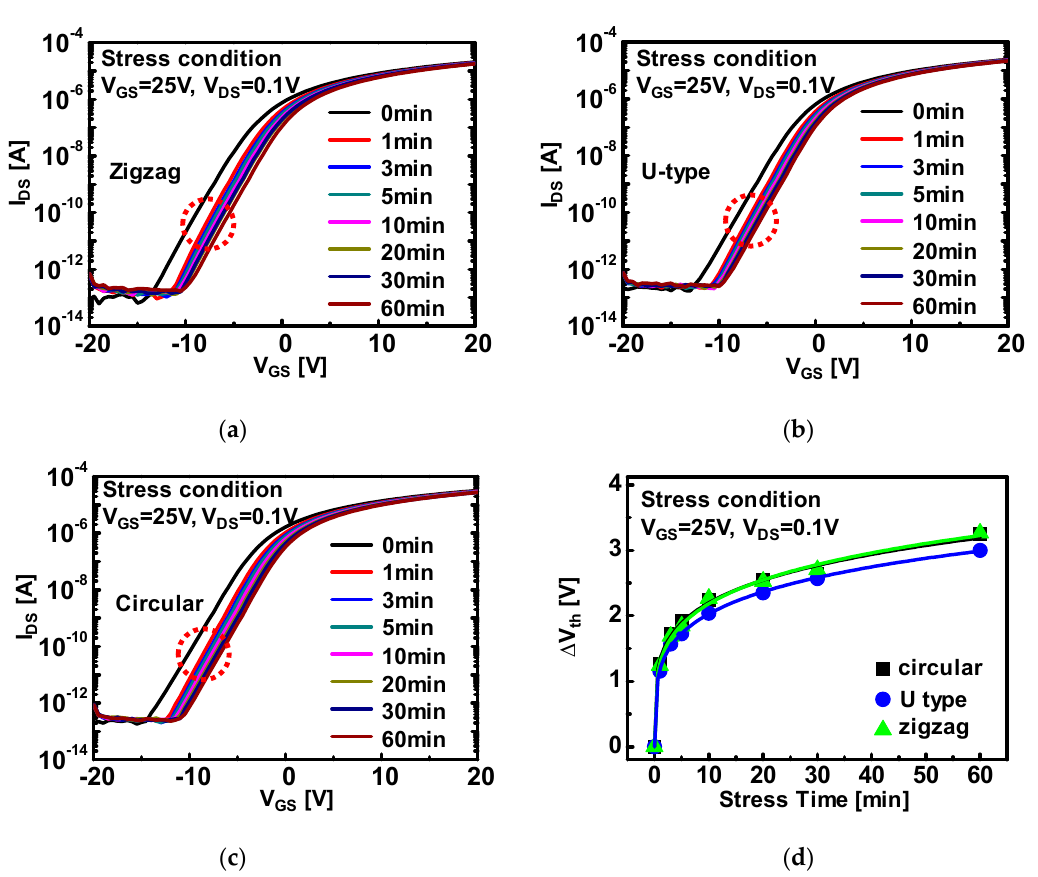
Figure 3. Transfer characteristics of ( a ) zigzag, ( b ) U-type, and ( c ) circular a-IGZO TFTs under bias stress condition of V GS = 25 V and V DS = 0.1 V. All of the bias stress tests were executed under 60 ◦ C substrate temperature for 60 min. Evolutions of threshold voltage shift depending on bias stress time under stress condition of ( d ) V GS = 25 V and V DS = 0.1 V.